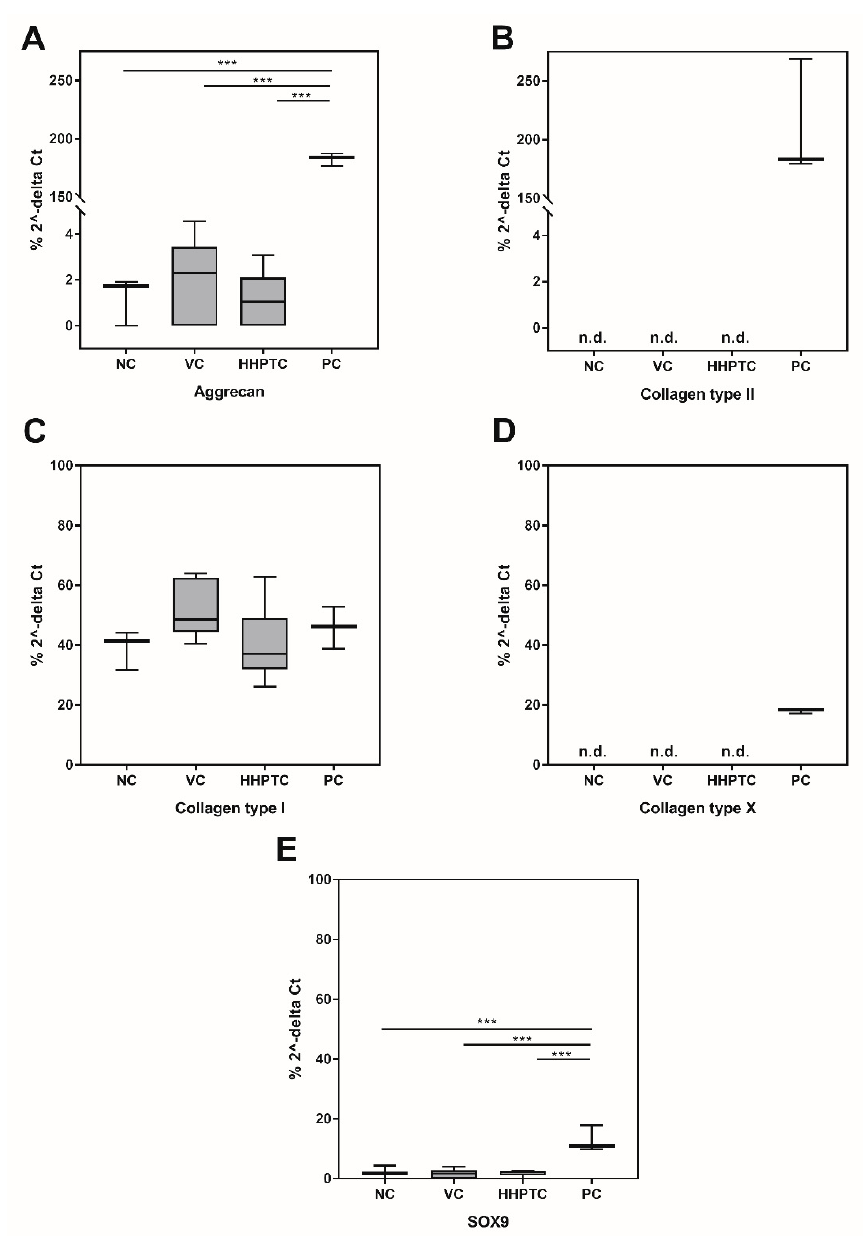
Figure 8. Relative gene expression (percentage of 2 − ∆ CT ) of relevant chondrogenic genes (( A ) aggrecan, ( B ) collagen type II, ( C ) collagen type I, ( D ) collagen type X, ( E ) SOX9) in spheroid cultures at day 35.